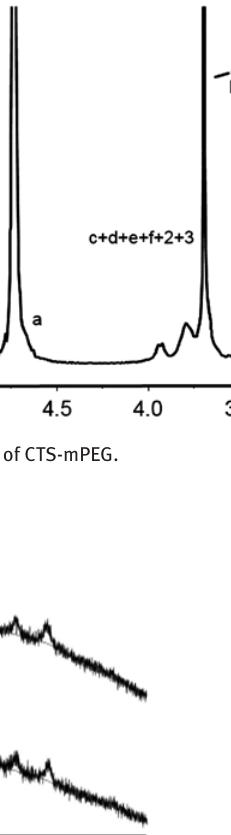
O @CTS-mPEG MNPs. 3 4